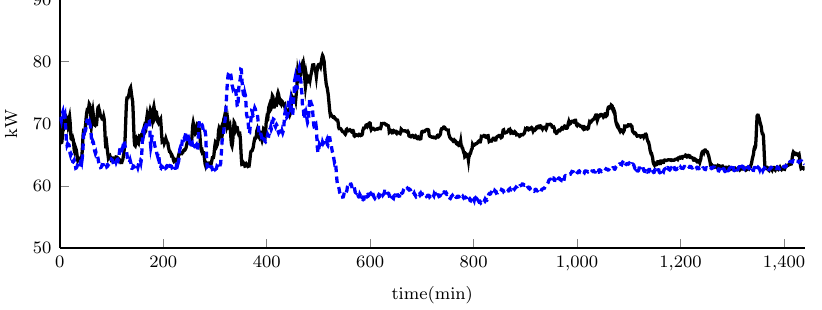
Figure 10. Total energy demand for a ( ) sunny day and a ( ) day with passing